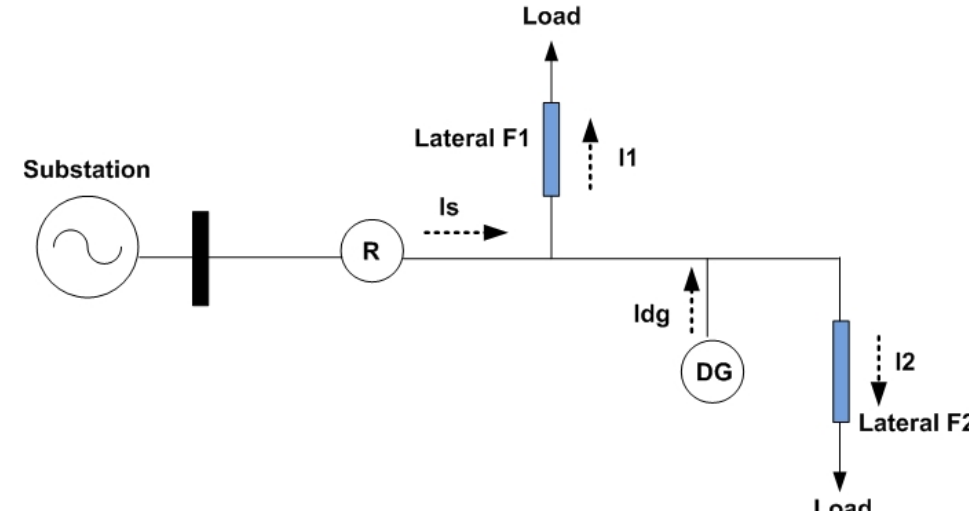
Figure 2. Topology of the simple power distribution network with a distributed generation (DG) source.